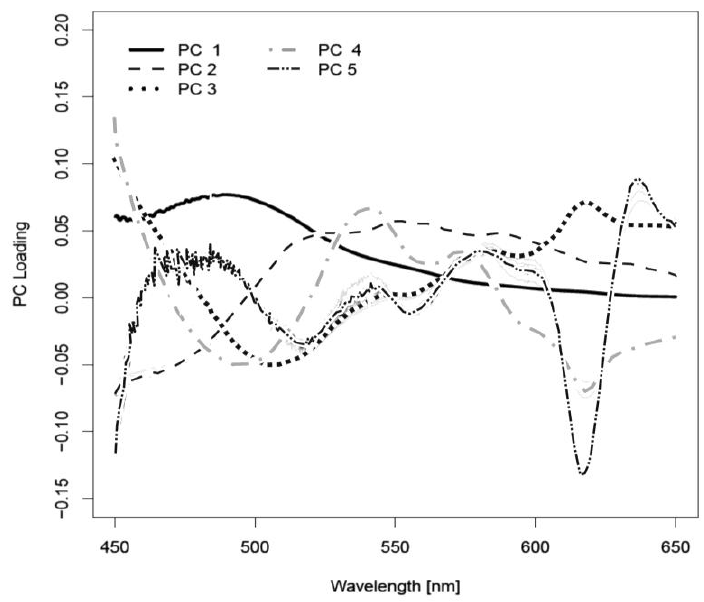
Figure 3. Averaged loadings of the principal components PC1–PC5 determined in 15 cross-validation